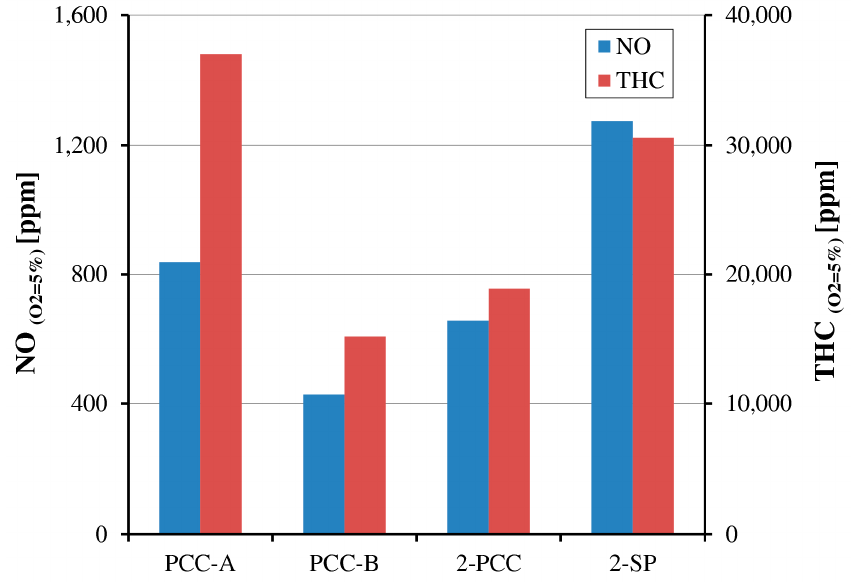
Figure 7. Emission of NO and THC for different ignition systems from one cylinder of GMVH-12.